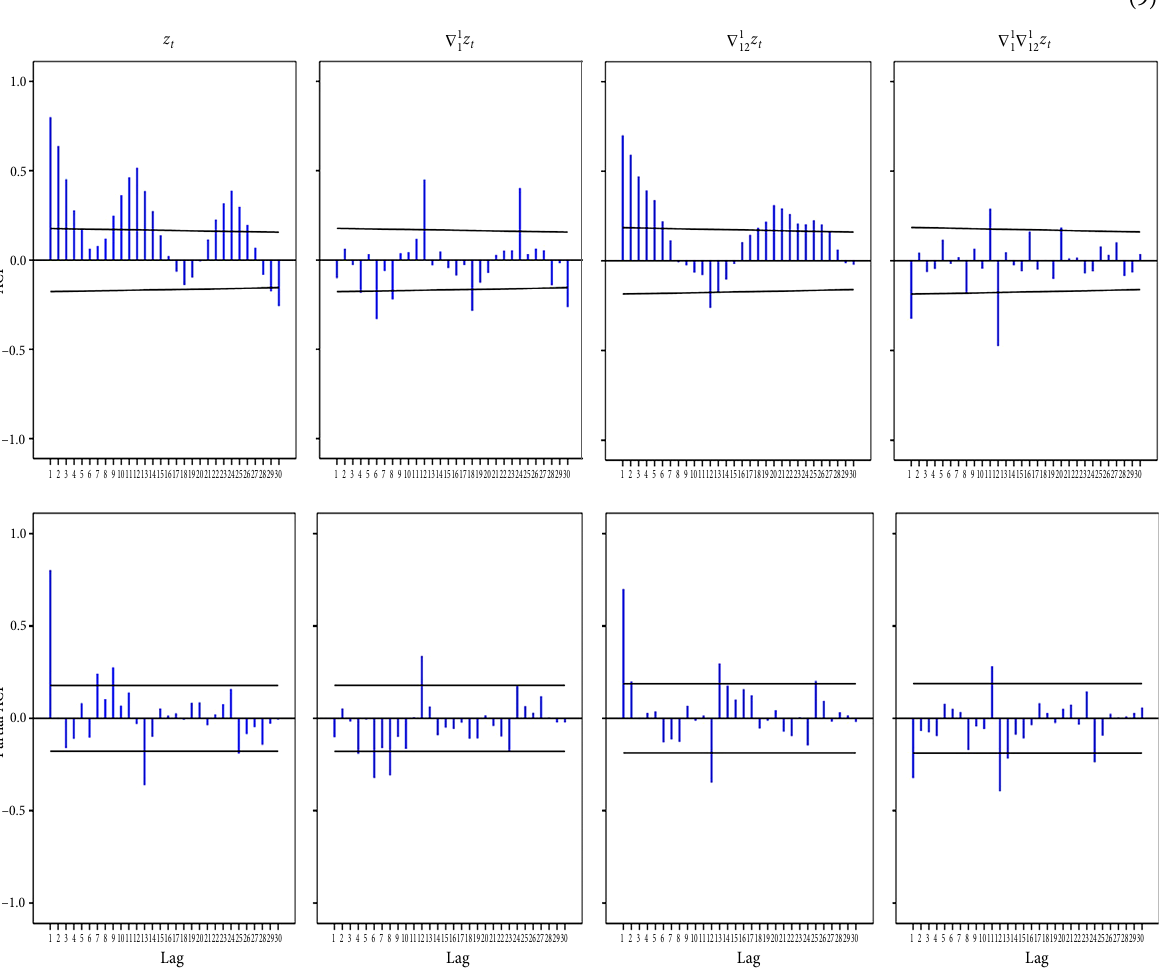
Figure 4. Sample ACF and PACF of the transformed rail passenger flow data. ACF/PACF plots for log transformed data ( z t , far left), lag-1 differenced series ( ∇ 1 z ), lag-12 differenced series ( ∇ 1 z ), and lag-1 and lag-12 differenced ( ∇ ∇ 1 1 1 t 12 t are displayed; the 95% confidence limits are represented by horizontal